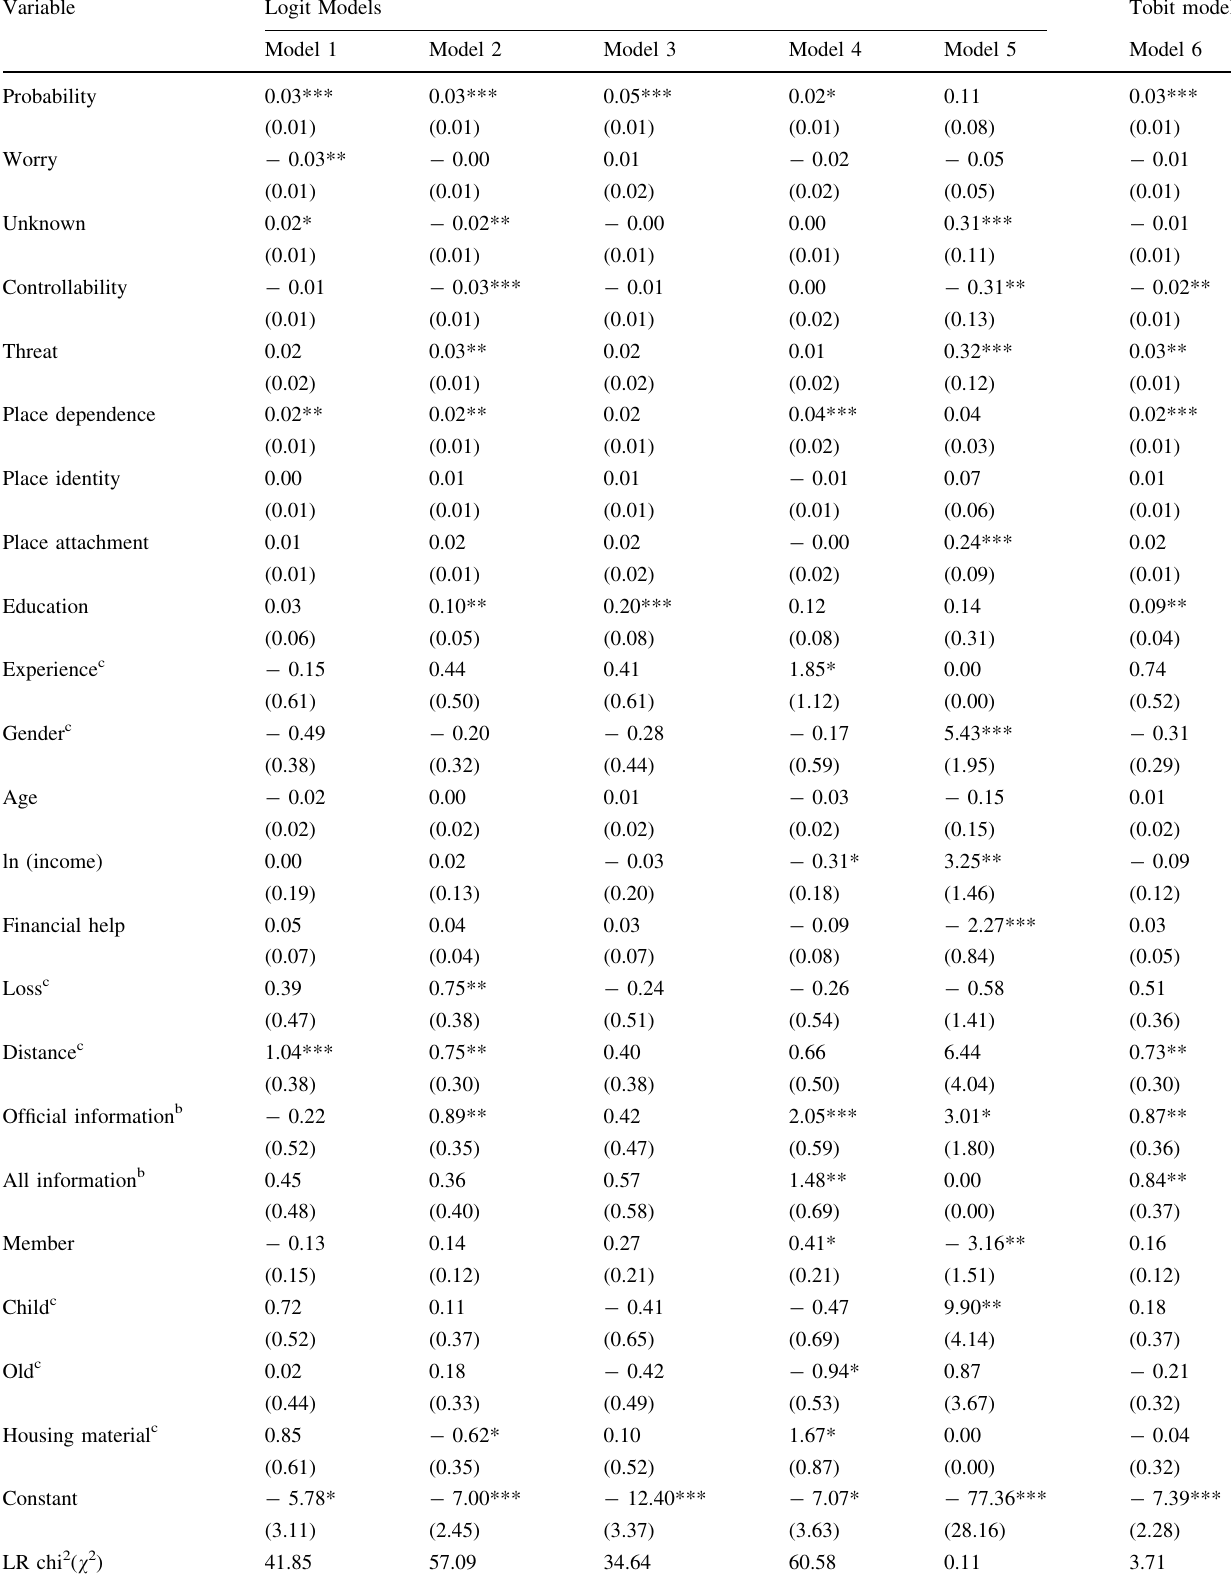
Table 7 Results of regression estimates of household disaster preparedness variables and their potential influencing variables a in the